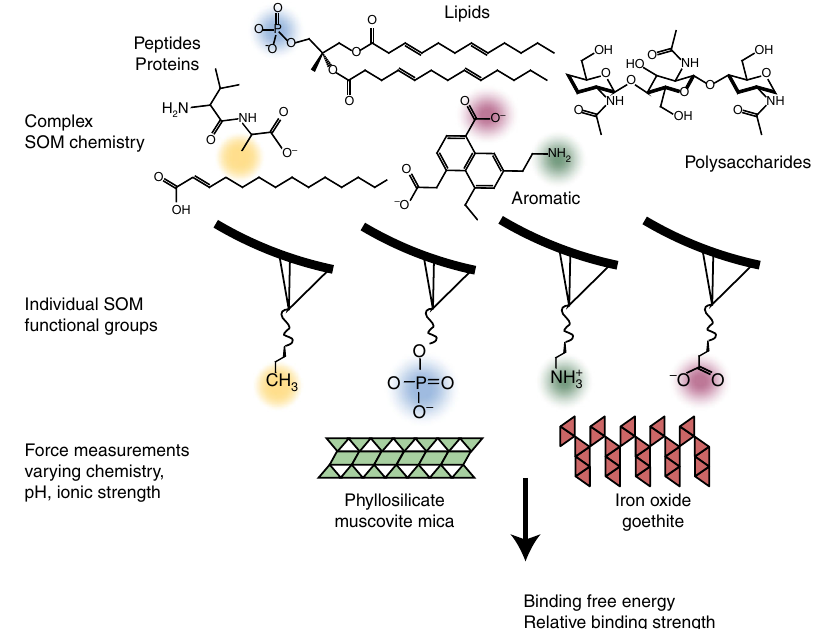
Fig. 1 Schematic of the experimental setup. Common chemical functional groups from soil organic matter (SOM) were chosen to represent a model for interaction between organics and two model minerals: muscovite and goethite. Performing force measurements between these model organics and minerals enable us to quantitatively evaluate the binding